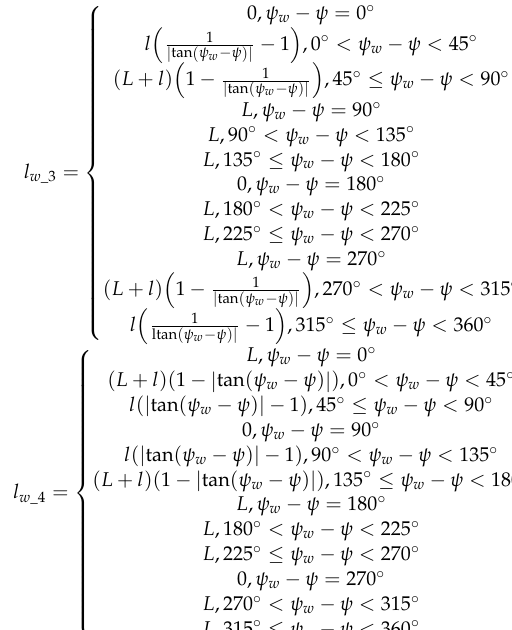
Figure 14. The coordinate system of wind load.